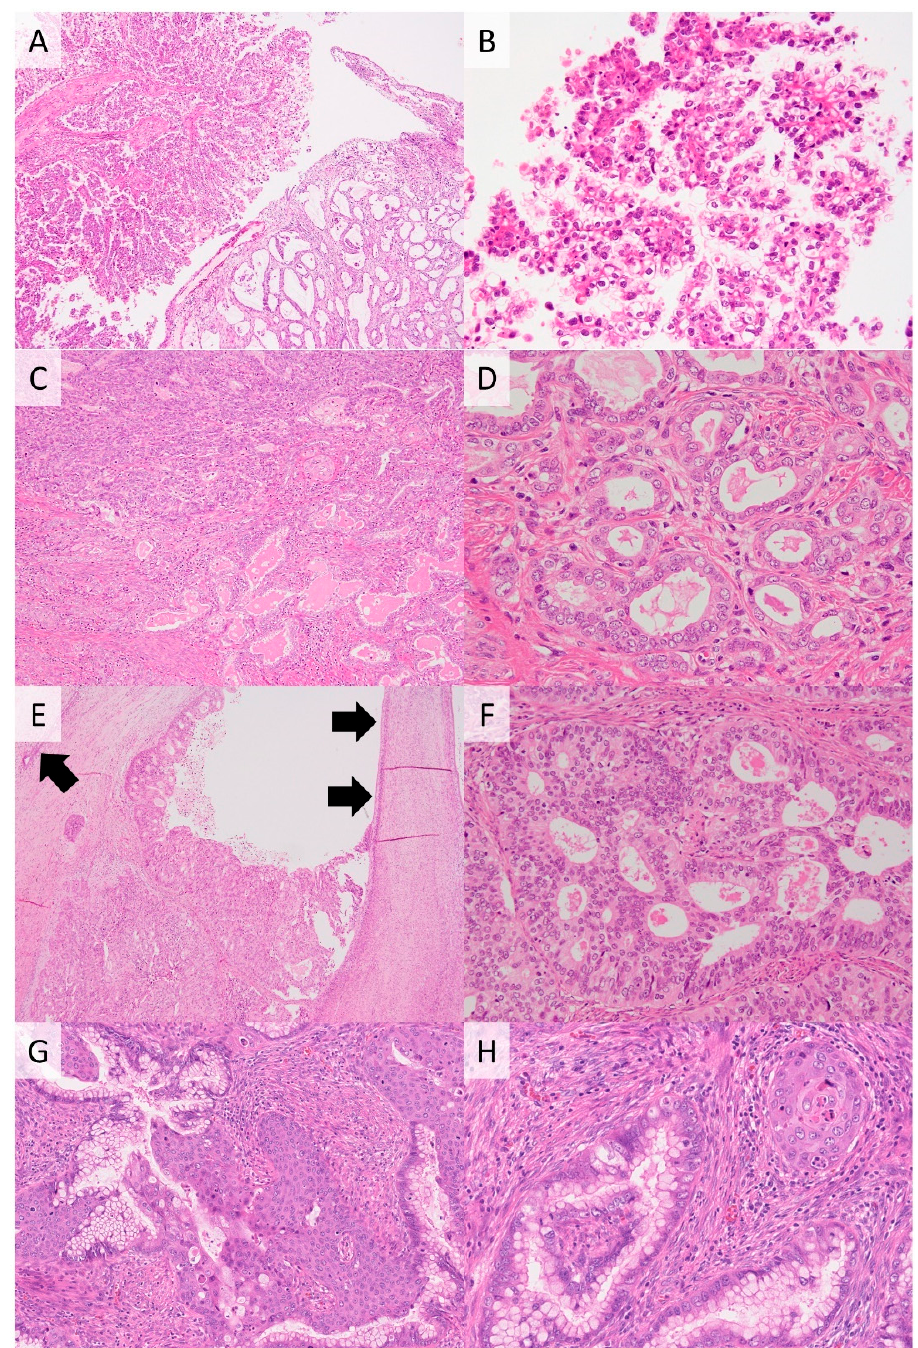
Figure 4. Other types of HPV-independent cervical cancers. Clear cell carcinoma showing papillary structure (upper left) and tubulocystic pattern (lower right) ( A ). Tumor cells have clear cytoplasm and enlarged nuclei with prominent nucleoli ( B ). Mesonephric carcinoma showing various histological patterns such as corded and spindled (upper left) and tubular pattern (lower right) ( C ). Cuboidal tumor cells with pale to eosinophilic cytoplasm forming glands with eosinophilic intraluminal secretions ( D ). Cervical endometrioid adenocarcinoma arising in endometriosis (( E ), black arrows). Columnar tumor cells showing cribriform glands ( F ). Gastric-type adenocarcinoma showing prominent squamous differentiation ( G ) and this tumor is an HPV-independent adenosquamous carcinoma ( H ). (( A , C , E , G ), H & E stain, ×100; ( B , D , F , H ), H & E stain ×200).